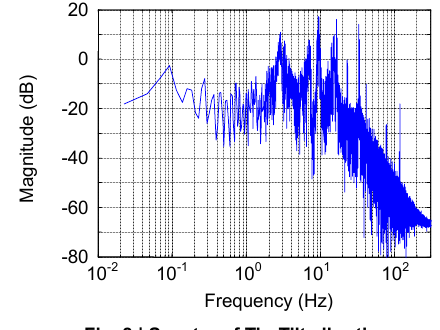
Fig. 8 | Spectra of Tip-Tilt vibrations.